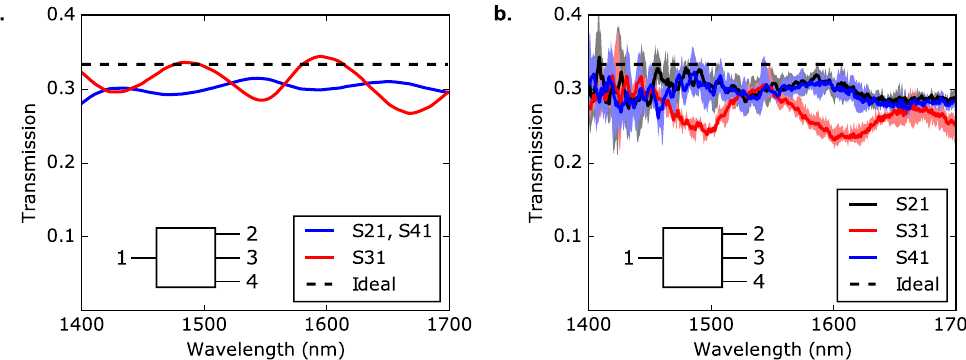
Figure 6. Simulated and measured S-parameters for the broadband 1 × 3 splitter, where Sij is the transmission from port i to port j . ( a ) Simulated performance, calculated using finite-difference time-domain (FDTD) simulations. Due to bilateral symmetry in the structure, S21 and S41 are equal to each other. ( b ) Measured device performance. Here, we have overlaid the measurements for 4 identically fabricated devices. The average values are denoted by the solid lines, and the minimum and maximum values are denoted by the shaded